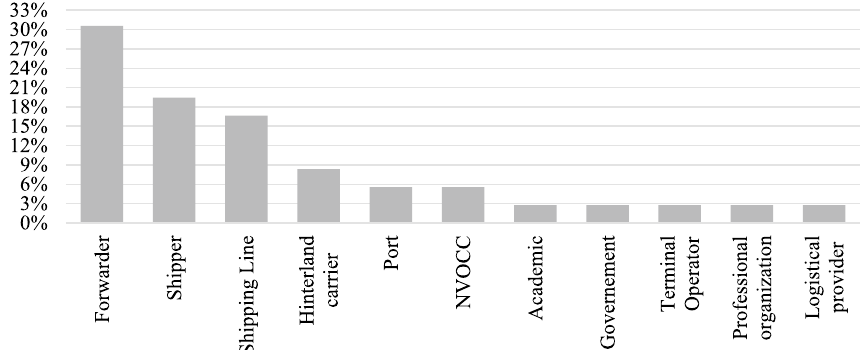
Fig. 5 Amount of respondents per category feasibility ranking. Source : own